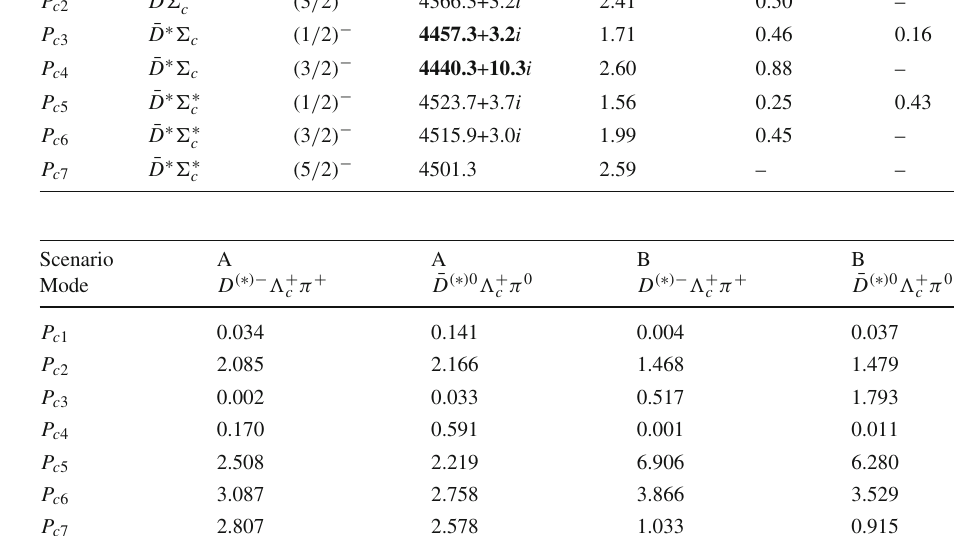
(in units of MeV) of P